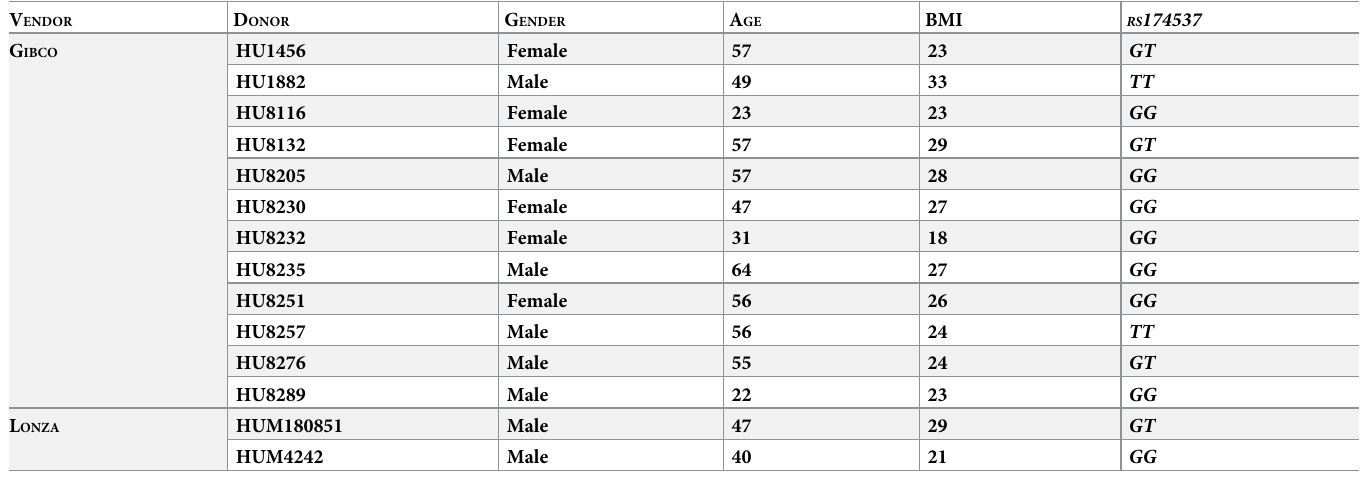
Table 1. Overview of primary human hepatocytes (PHHs) used in the experiments.